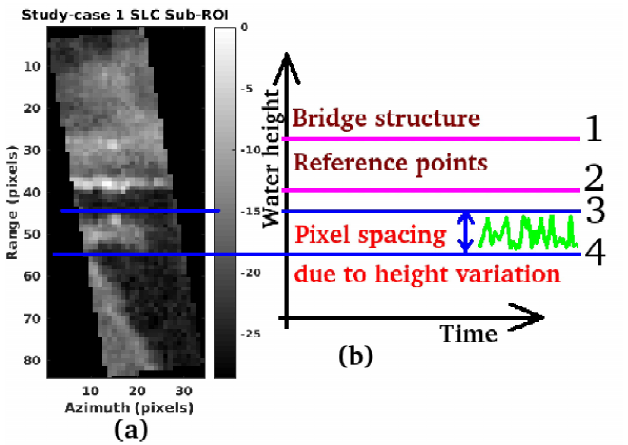
Figure 12. Case study 2 Sub-ROI parameters. ( a ): Sub-ROI SAR image representation in the slant coordinates. ( b ): Scattering parameters on the reference points and pixel spacing trend.